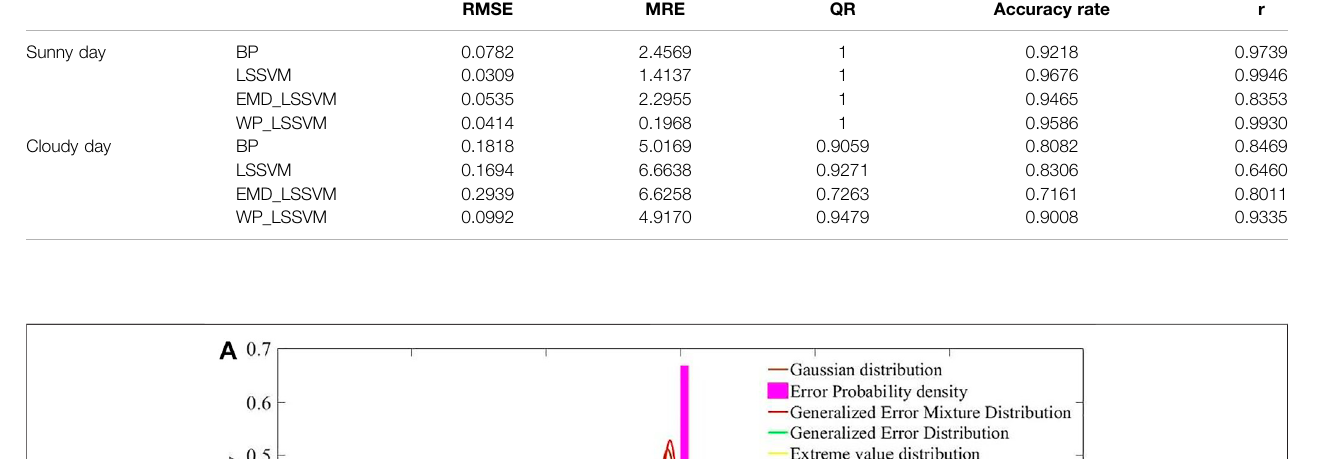
RMSE MRE QR Accuracy rate